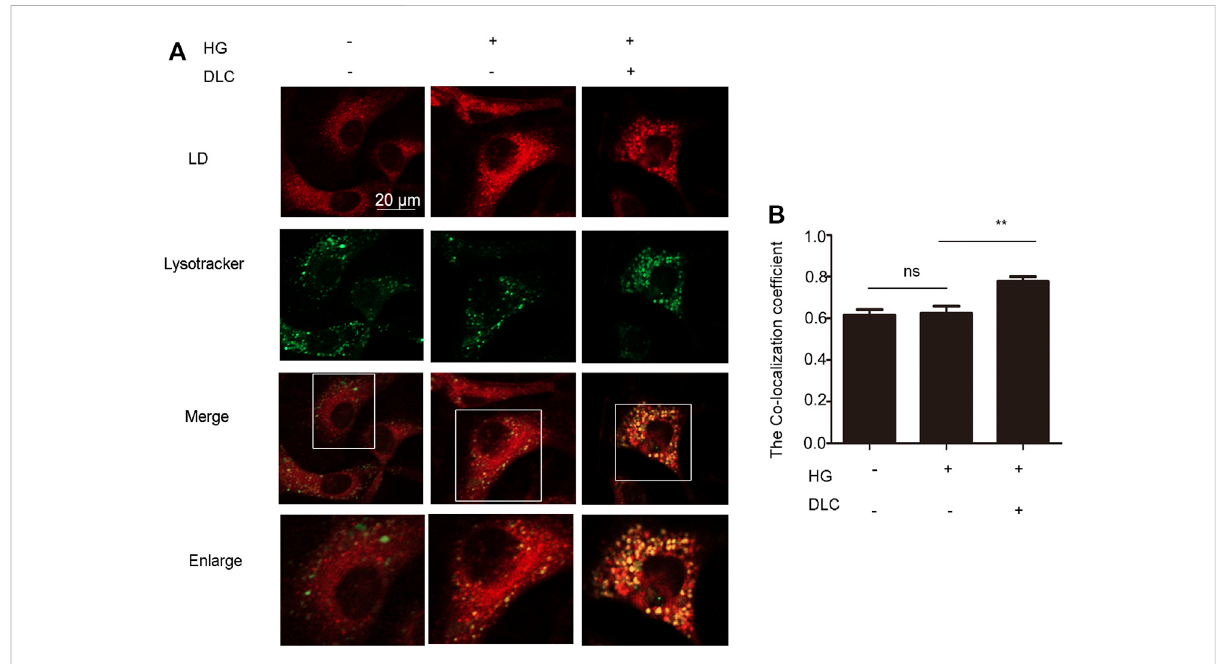
FIGURE 5 DLC promoted translocation of LD to lysosomes and LDs degradation. (A,B) : Co-localization of lysosomes and LDs was detected by immuno fl uorescence after HUVECs were treated with DLC (1 μ M) for 24 h under HG condition (30 mM). Scale bar: 20 μ m, ** p < 0.01, n =